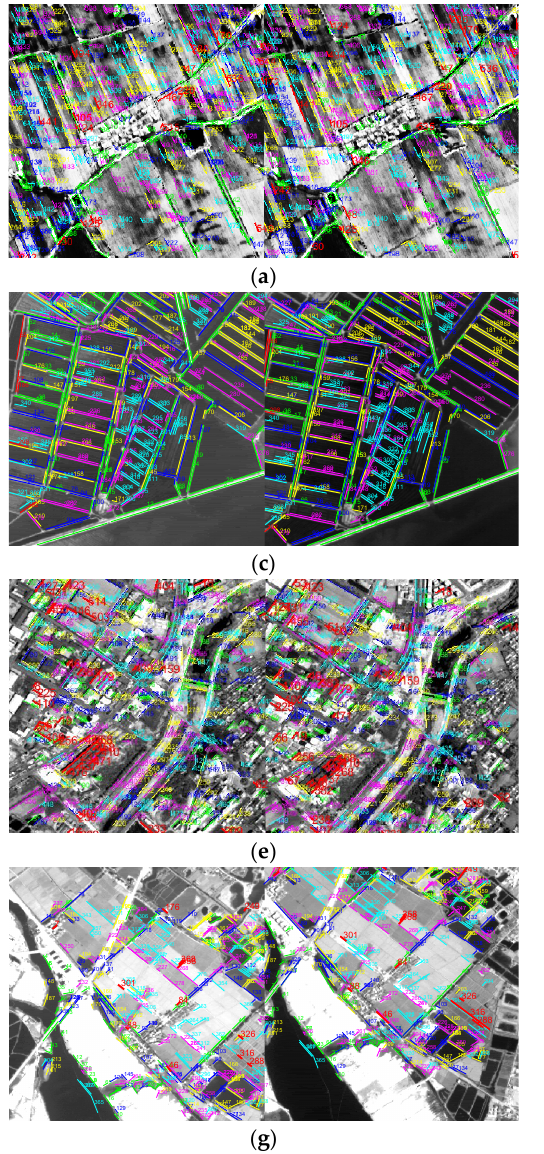
Table 1. Comparison of proposed approach and two state-of-the-art line matching approaches (LJL and N-LPI) for 8 image pairs.